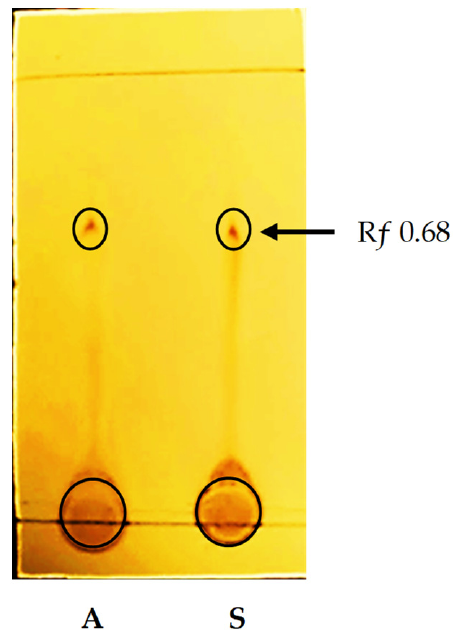
Figure 6. TLC image for the melanin from G. oxydans FBFS 97. Extracted melanin (A), and the reference standard (S).